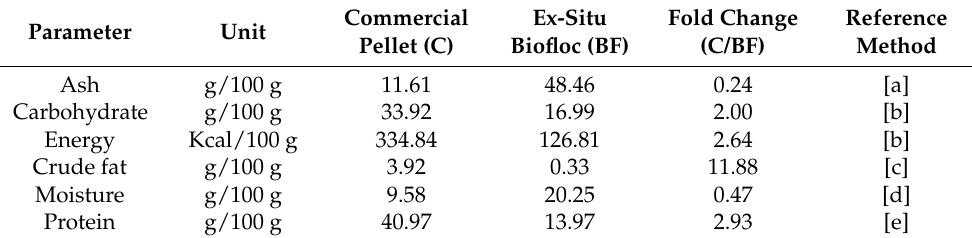
Table 3. Proximate analysis between commercial pellet and ex-situ biofloc.